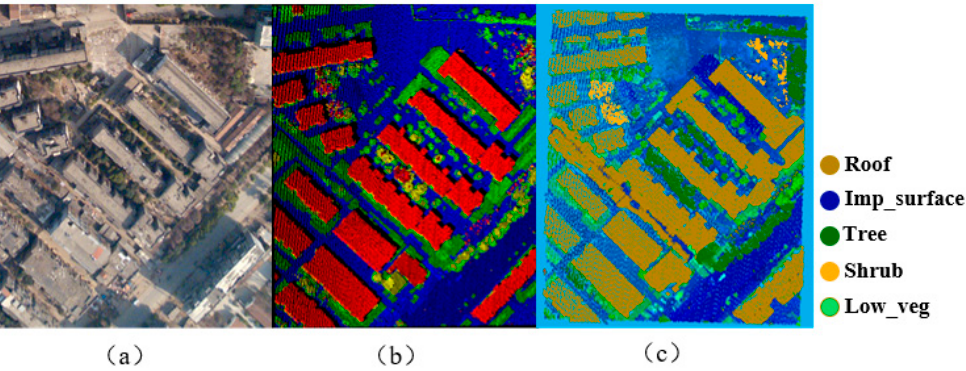
Figure 7. Image ( a ), TerraSolid classification results ( b ), and MSMF-PointNet classification results ( c ) in Shashi area.